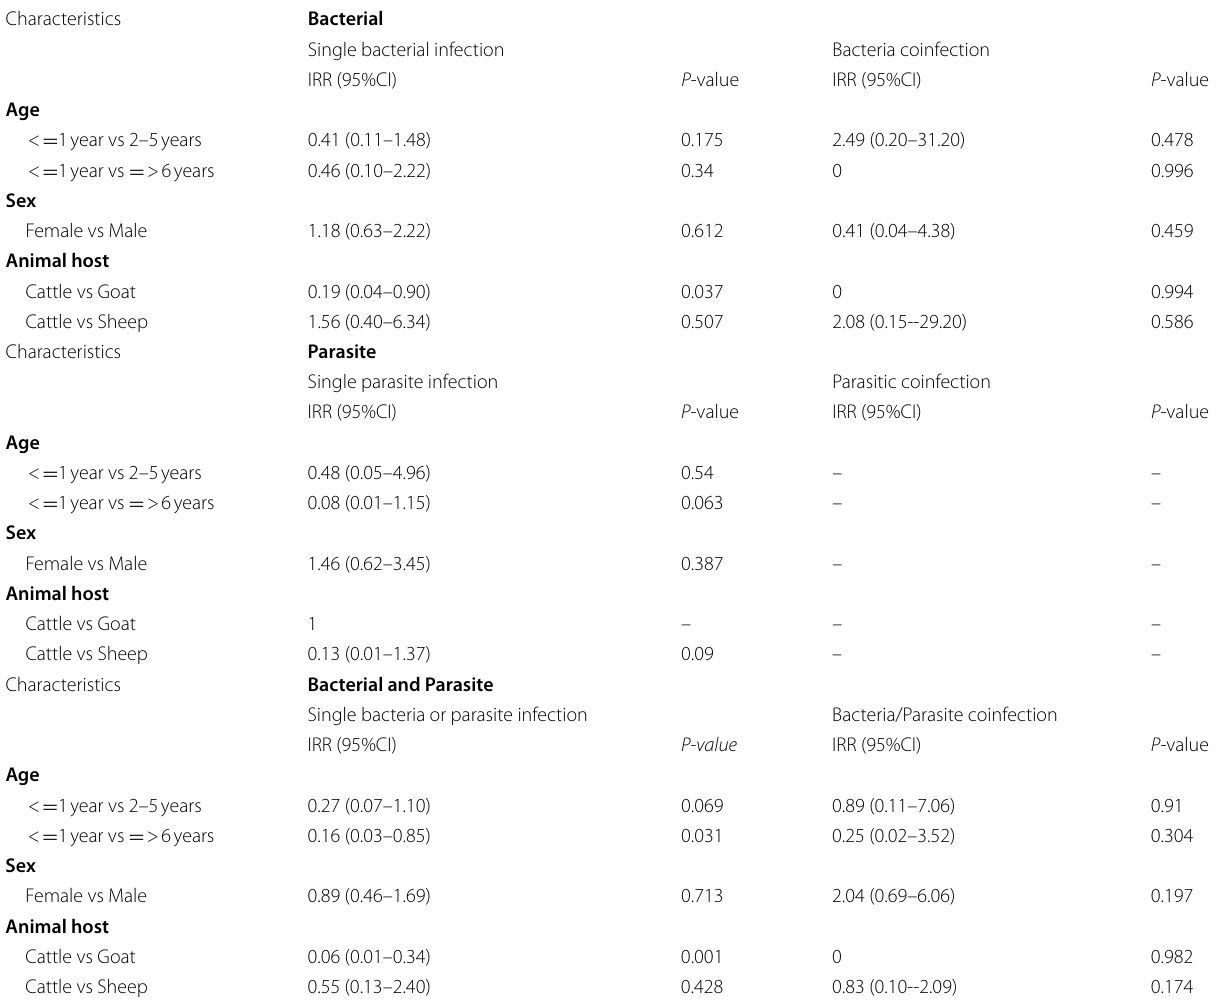
Table 4 Multivariable multinomial logistic regression model for tick‑borne bacterial and parasitic